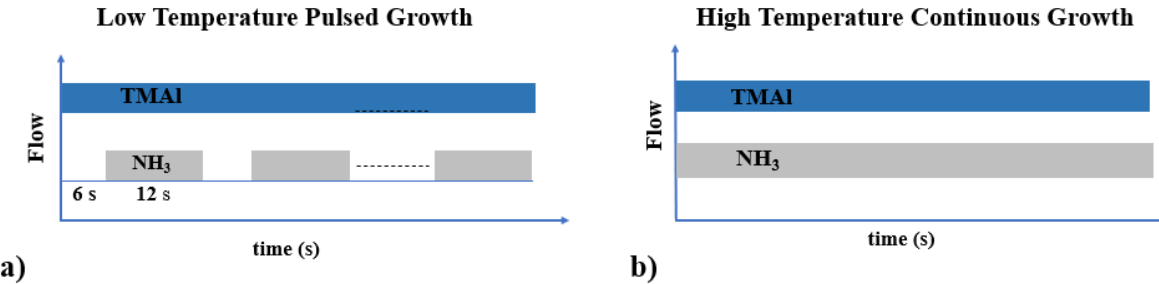
Figure 1. Schematic diagram for the MOCVD growth process of AlN showing ( a ) a low temperature precursor pulsed growth, ( b ) a high temperature continuous growth. N 2 carrier-based growth involves a simpler approach consist of process (a + b). To avoid cracking in similar thickness, the H 2 carrier-based process involves process (a + b + a + b).